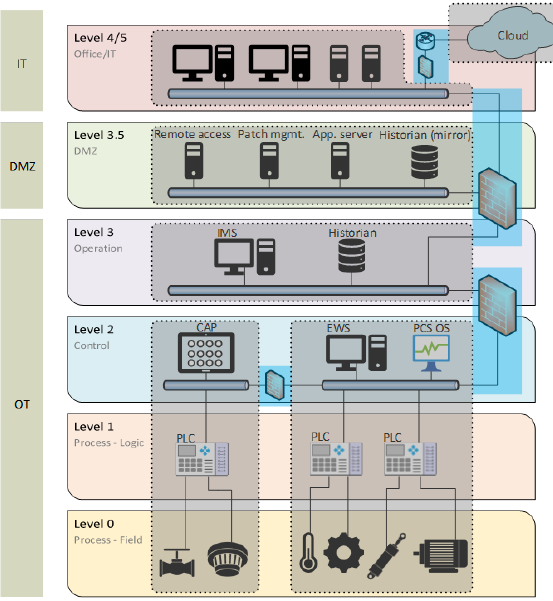
Figure 1. Example of network topology for an industrial facility. In addition to the Purdue levels, the figure also shows how components can be divided into zones (gray) and conduits